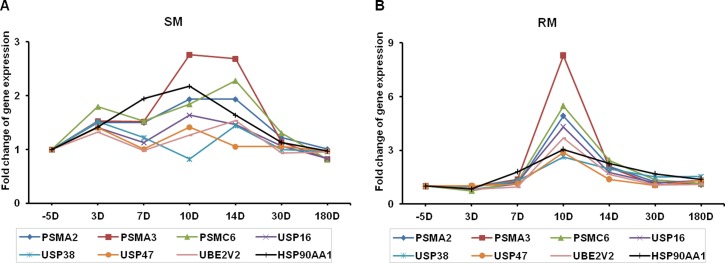
Fold-changes in gene expression involved in the protein ubiquitination pathway in SMs (A) and RMs (B) after SIV infection (range: 5–180 days). Eight genes are differentially expressed, including Proteasome subunit alpha (PSMA) type-2 (PSMA2), type-3 (PSMA3), ATPase subunit Rpt4 (PSMC6), ubiquitin specific peptidase 16 (USP16), USP38, USP47, ubiquitin conjugating enzyme E2 variant 2 (UBE2V2) and heat shock protein 90kDa alpha family class A member 1 (HSP90AA1). The p-values in the RM group are statistically significant (p<0.05): PSMA2, p = 0.003; PSMA3, p = 0.003; SMC6, p = 0.03; USP16, p = 0.004; USP38, p = 0.03; USP47, p = 0.002; UBE2V2, p = 0.002; HSP90AA1, p = 0.006.